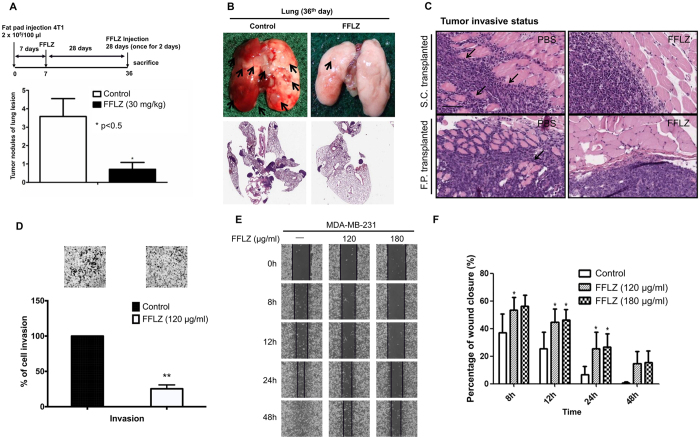
FFLZ inhibits spontaneous pulmonary metastasis in mouse lungs and reduces the invasion of breast cancer cells.(A) Balb/c mice were transplanted with 4T1 cells and treated with FFLZ (30 mg/kg) as described in Fig. 1. Tumor nodules of lung lesion in FFLZ post treatment experiment. (B) Pictures of lung lesions from 4T1-bearing mice and quantitation of the nodules of lung lesions. (C) Hematoxylin and eosin (H&E) staining from tumor lesions, smooth edge encircling indicated by black arrows. Scale bar, 100 μm. (D) Invasion ability of MDA-MB-231 cells was quantified by counting the number of cells that migrated to the underside of the porous polycarbonate membrane under microscopy and normalized to the control group. Data are expressed as the mean ± SD (N > 5) by Student’s t test; one of three independent experiments is presented. (E) Wound closure assays in MDA-MB-231 cells. Images were captured at 0–48 h in serum-free medium in the presence of FFLZ (0–180 μg/ml) or PBS. (F) Percentages of wound closure at 0–48 h under each condition as plotted, in which the wound width was normalized to the initial value at 0 h.